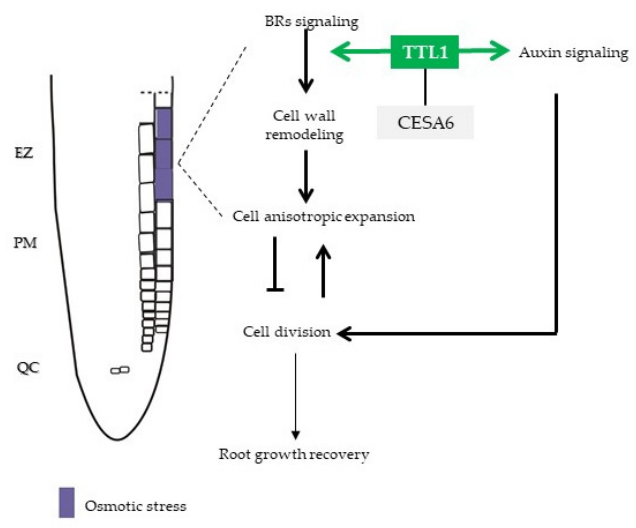
Figure 9. Model that illustrates a scenario for primary root growth recovery during osmotic stress. Osmotic stress is perceived in epidermal cells of EZ and integrates through TTL1 in the BR/auxin signaling pathway that regulates balanced root growth. TTL1 maintain cell wall integrity to sustain cell anisotropic expansion necessary to continuous primary root growth. EZ: Elongation Zone; PM: Proximal Meristem; QC: Quiescent Center; BR: brassinosteroid.